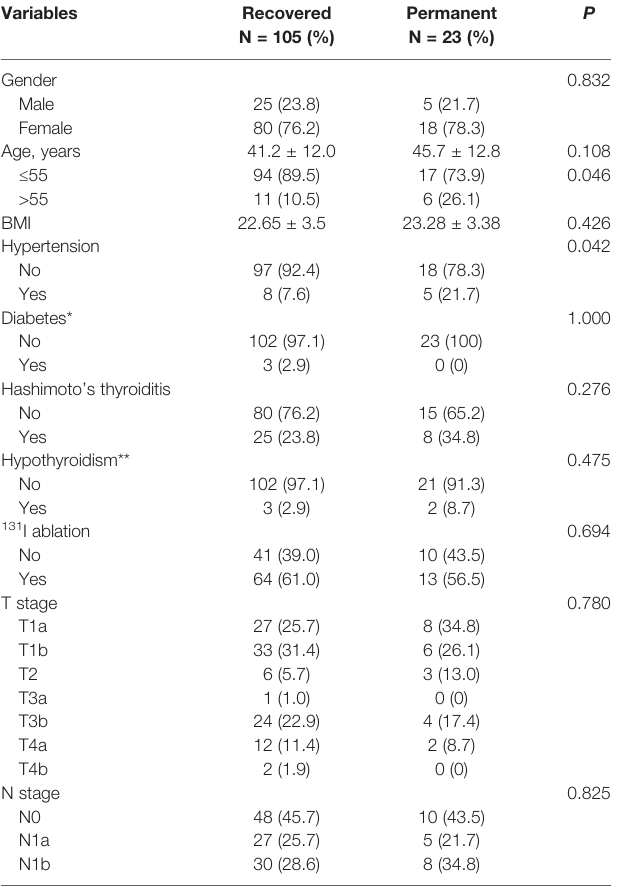
TABLE 1 | Demographics of patients with protracted hypoparathyroidism who recovered the parathyroid function or developed permanent hypoparathyroidism. Variables Recovered N = 105 (%)